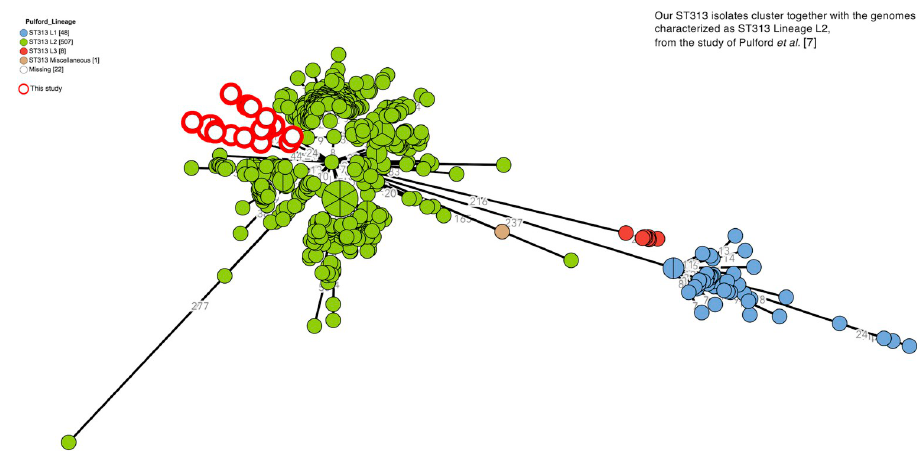
Fig 3. Clustering of S . Typhimurium ST313 human and rat isolates with ST313 Lineage 2 isolates described by Pulford et al . [7]. Minimum spanning tree (MSTree V2) comparing the S . Typhimurium ST313 genomes analyzed by Pulford et al. [7] in 2021 and the genomes in this study. The ST313 genomes in this study (circled in red, filled in white) cluster together with the Lineage 2 strains in the study by Pulford et al . [7], colored in green).